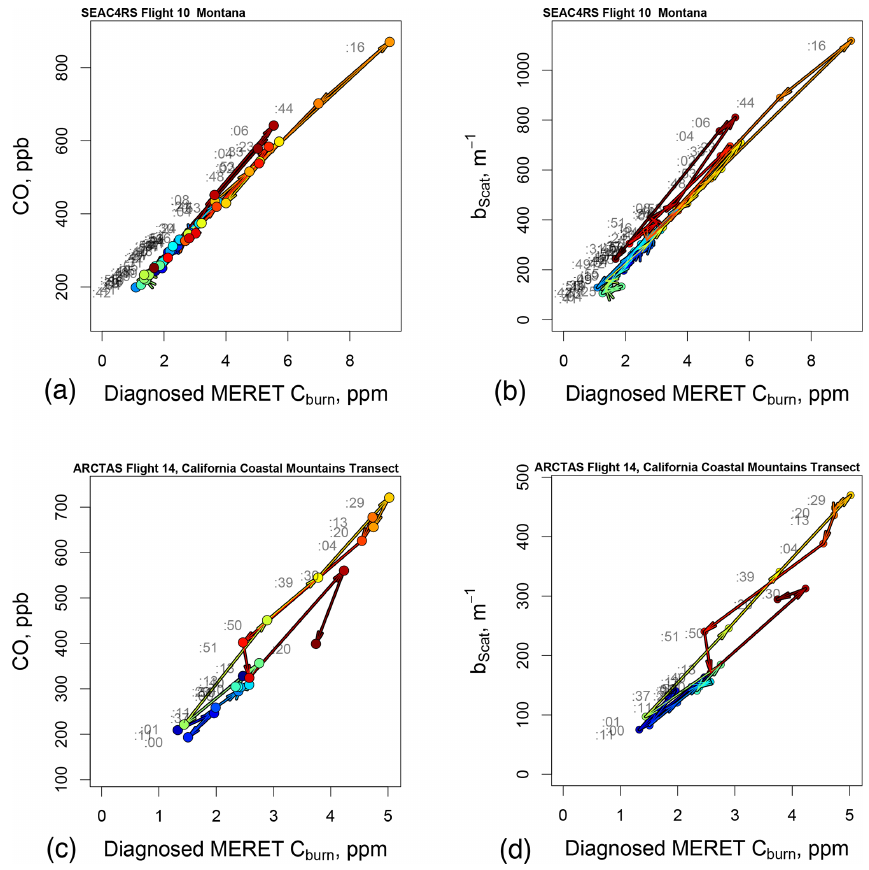
Figure 10. Analyzed relation of tracers to carbon burned using MERET for portions of SEAC4RS Flight 10 and ARCTAS Flight 14. Compare panels (a) through (d) with Fig. 4b, c, e, and f. Colors key the observations to times shown in the timelines in Fig. 4a and c. Light gray numerals give observation times in